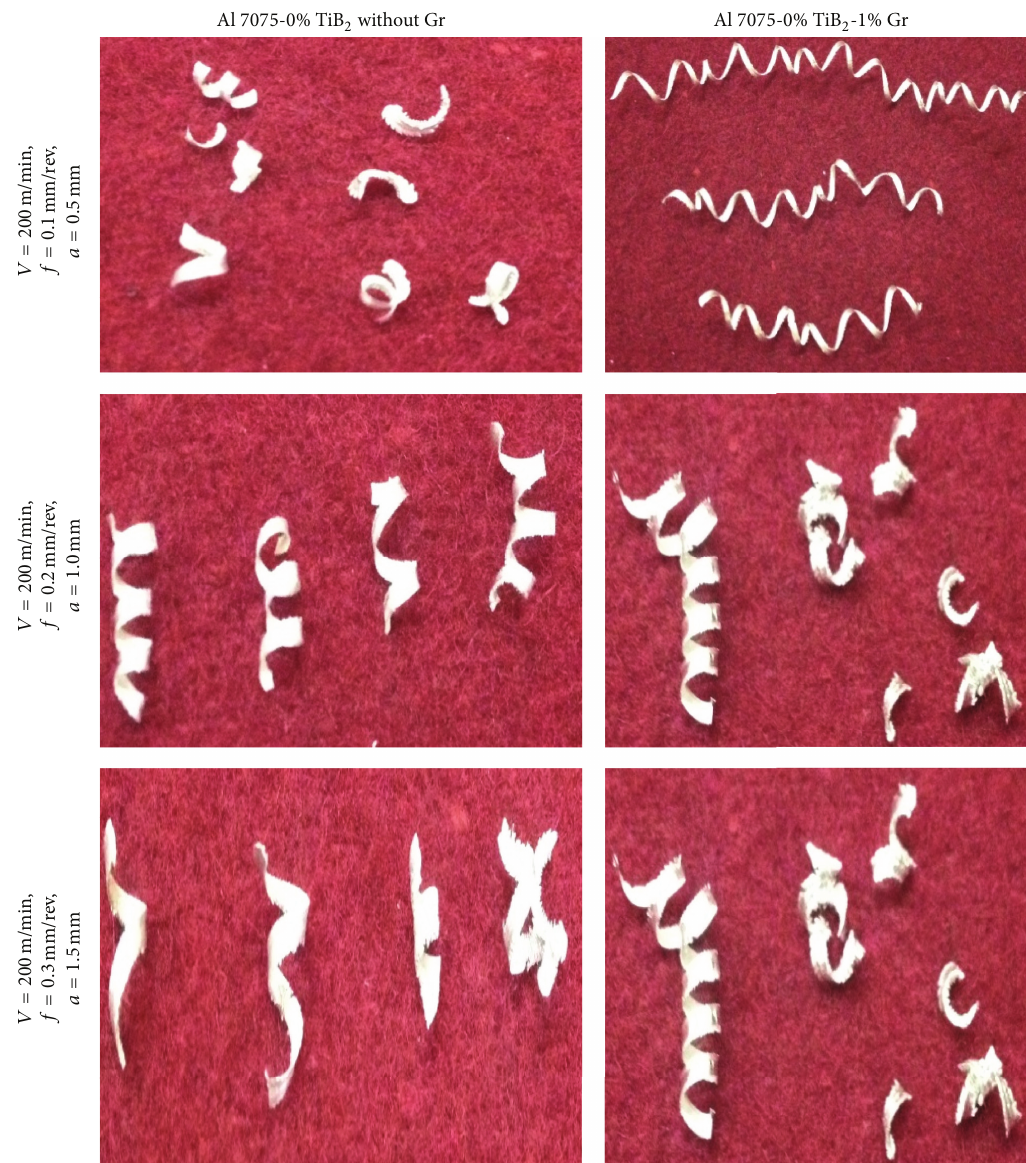
Figure 10: Examination of chip morphology with selected cutting parameters of AA 7075-3% TiB 2 -0% Gr and AA 7075-3% TiB 2 -1% Gr hybrid in situ composite with the cutting tool of 0.8 nose radius